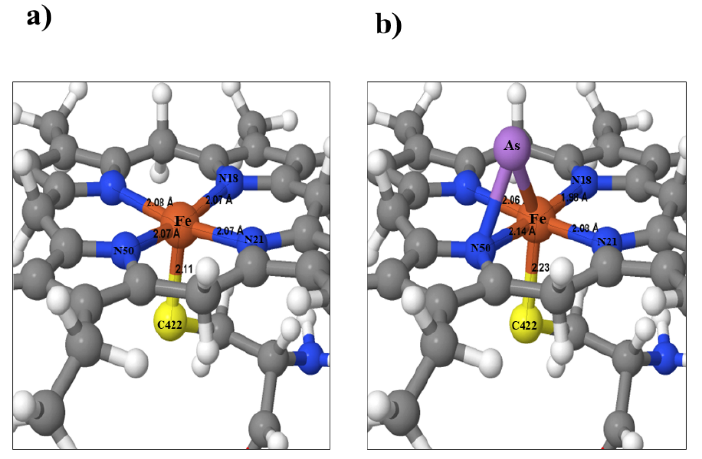
Figure 4. Close-up view of the Fe nucleus of the optimized form structures of the heme group atoms. ( a ) The control structure, ( b ) the molecular structure with